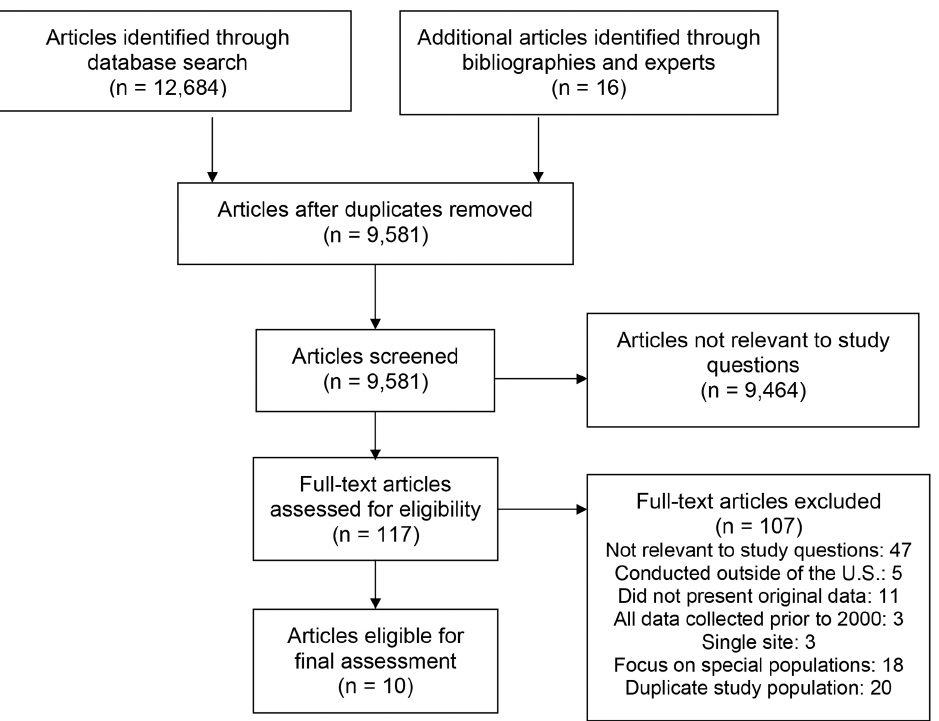
Figure 1. Summary of Article Search, Screening, and Selection Process.